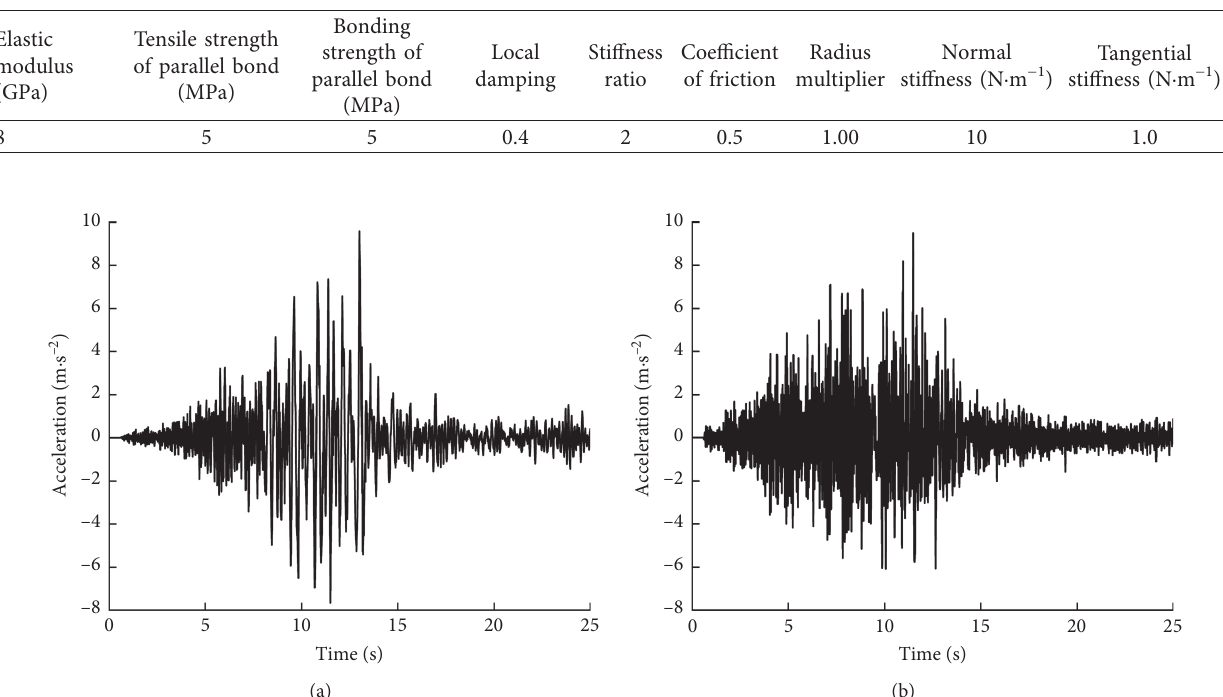
Table 3: Mesoscopic parameters of sandstone joints.